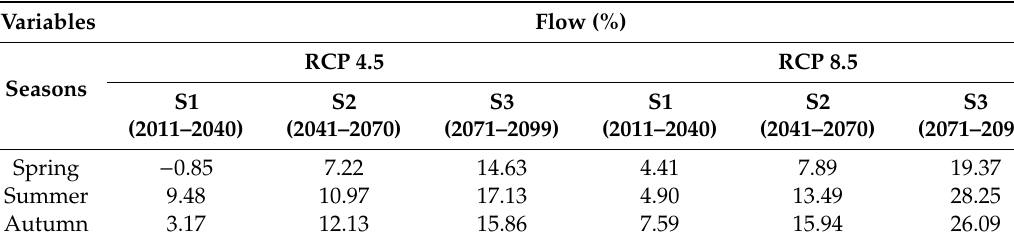
Table 9. Relative change (%) of the 30-year average seasonal flow during three future periods for RCP scenarios 4.5 and 8.5 in South Korea. The values were calculated by first converting the daily data into seasonal data. Next, the relative change of 30-year average seasonal flow for 13 GCMs was calculated for each period, and the average of the relative change of 13 GCMs was determined.